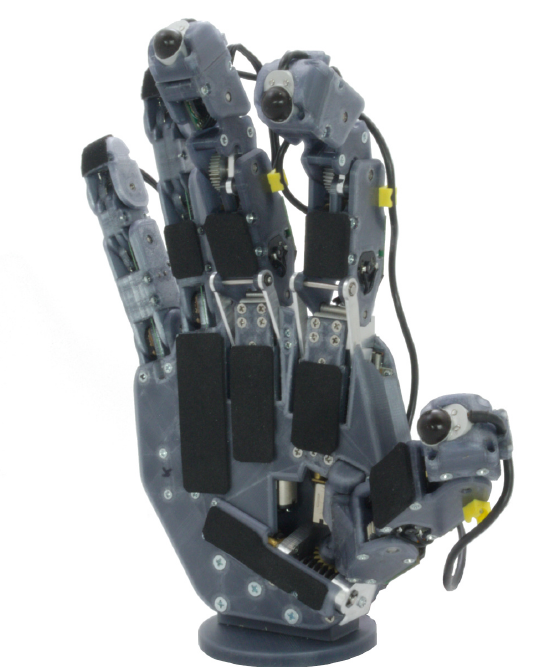
Figure 1. PUT-Hand—An open source dexterous robotic